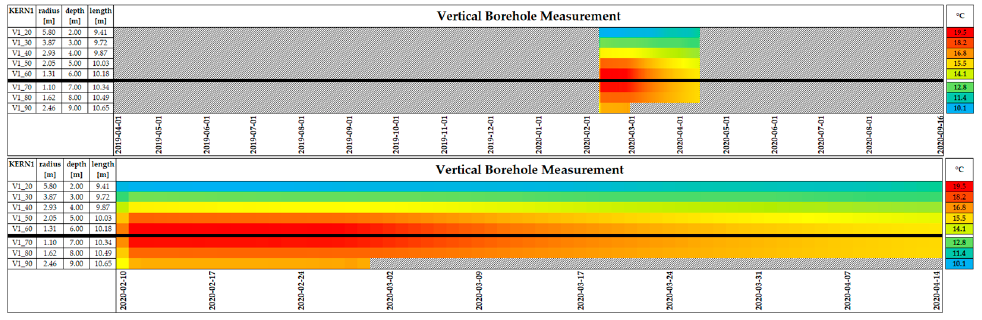
Figure 21. KERN1 vertical borehole temperature profile.